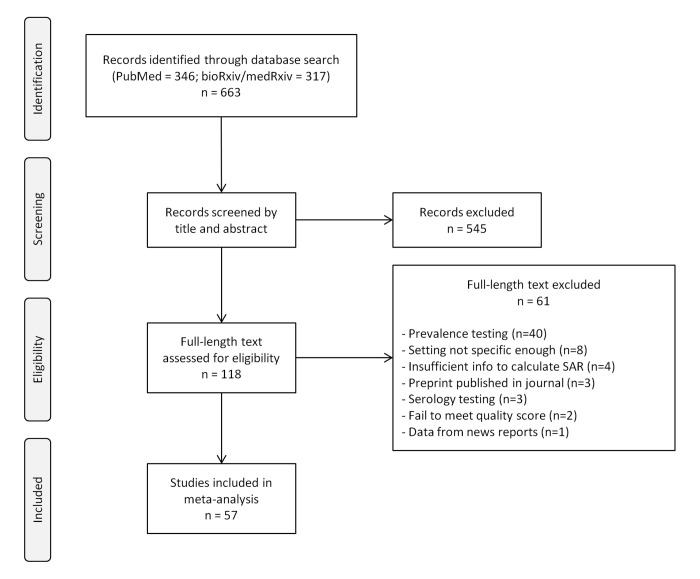
Flow chart of search strategy and study selection for the secondary attack rate (SAR).